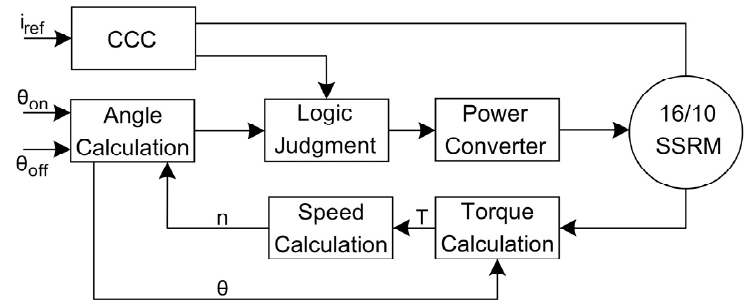
Figure 11. The basic control diagram of the digital control system of 16/10 SSRM. Notes: θ on , θ off , and θ denote turn-on, turn-off angle, and rotor position, respectively.